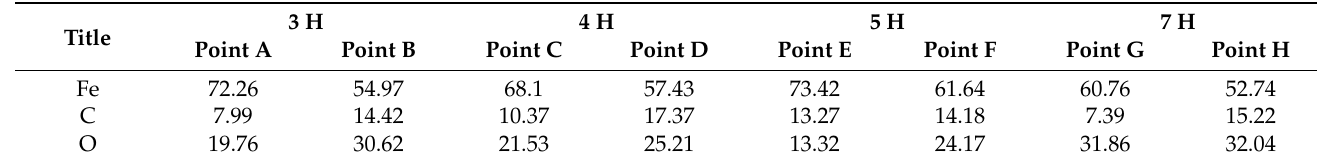
Table 2. The main elements and content in corrosion products at the black-gray area under different corrosion times beyond 3 h (wt.%).